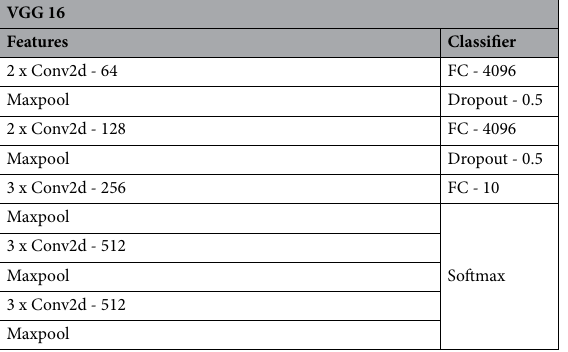
Table 1. Applied VGG 16 configuration. All 2d convolution kernels have a receptive field size of 3 x 3 pixels. A ReLU activation function is applied after the Convolution- (Conv2d) and Fully Connected layers (FC). During training two Dropout layers randomly zeroes some FC elements with a probability of 0.5. Finally, the output ppp is calculated by applying a Softmax activation